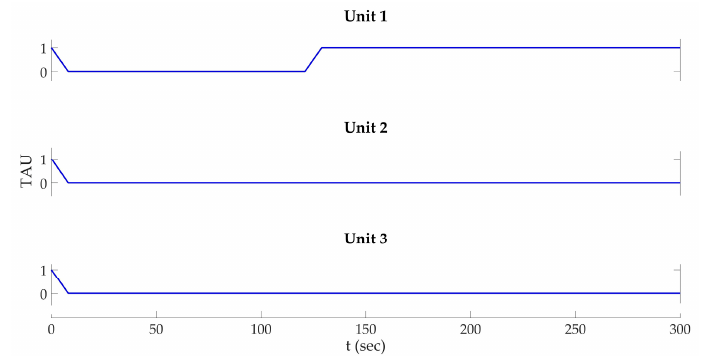
Figure 3. Valve opening for case c.